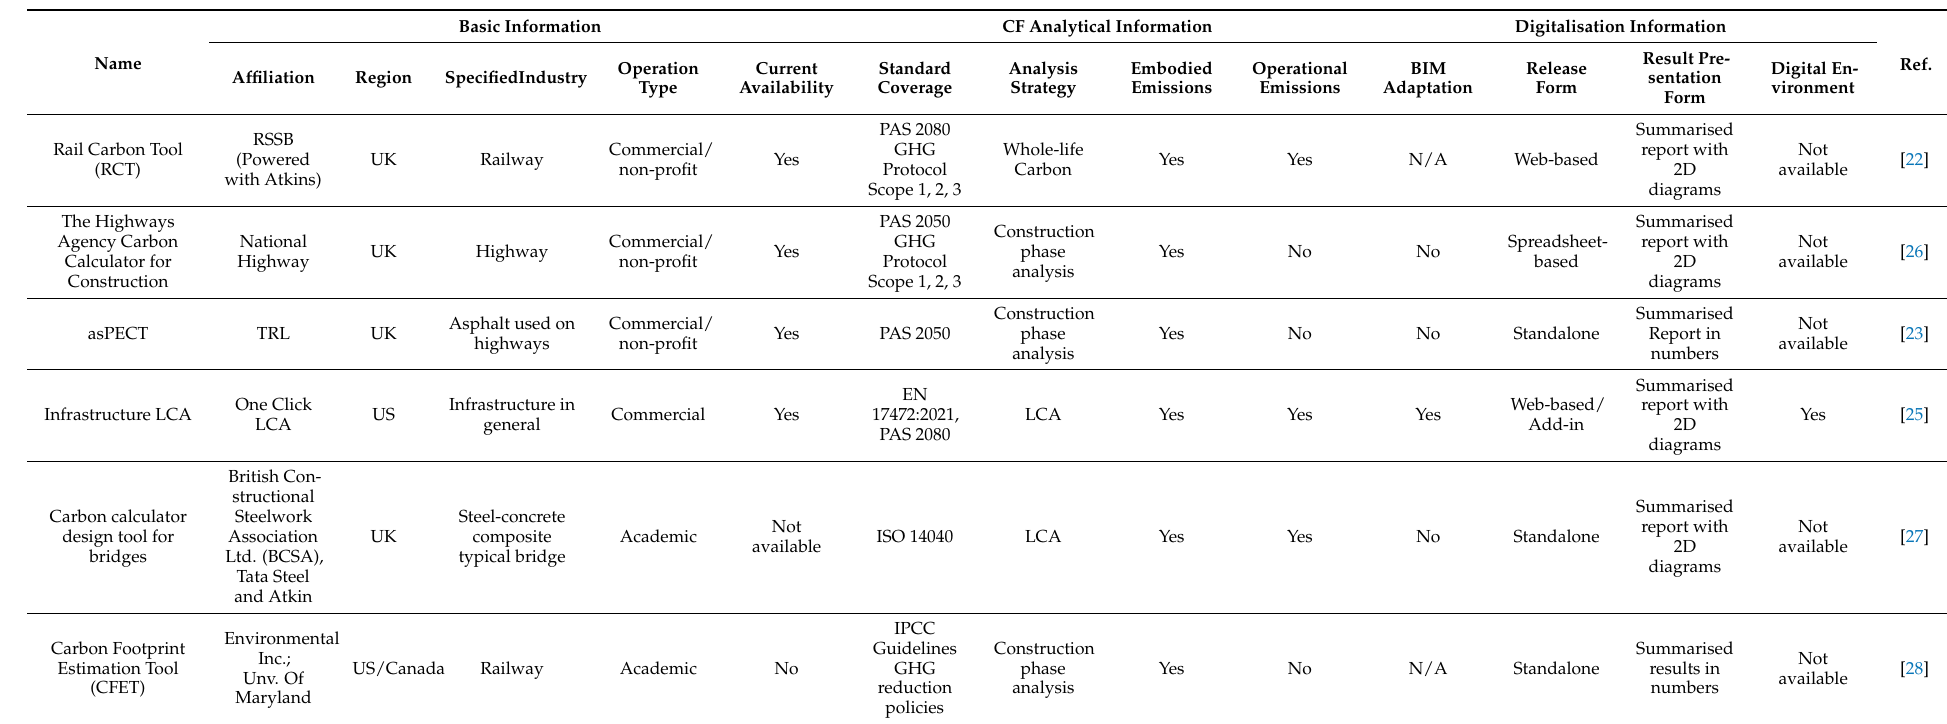
Table 2. Summary of digital tools in infrastructure